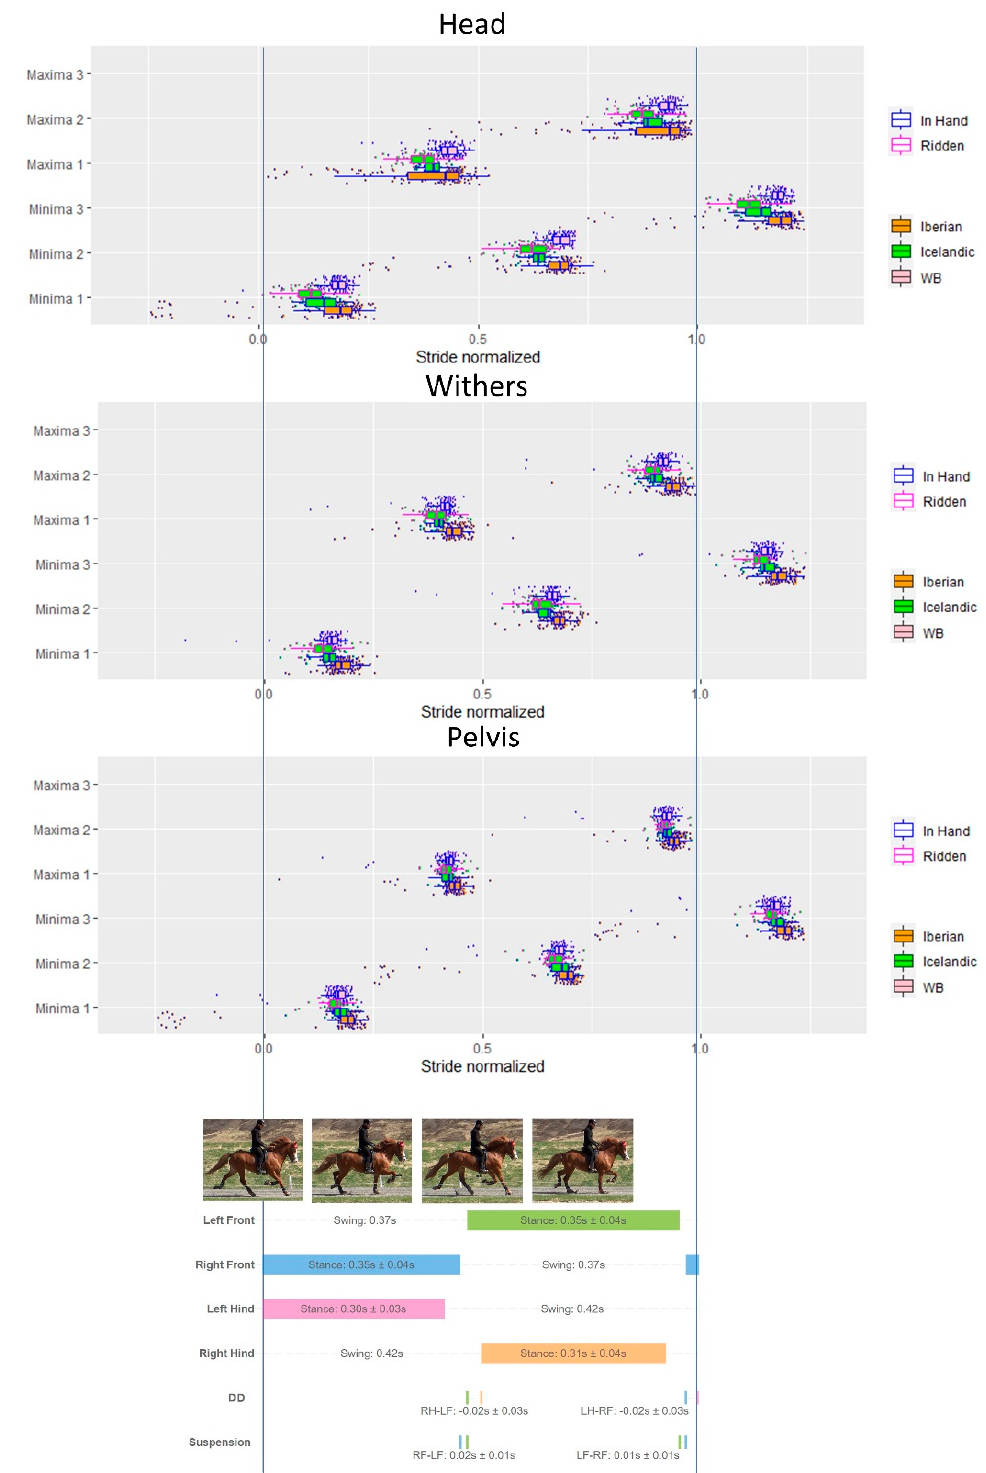
Figure 4. Combined data for the three breeds (Iberian, Icelandic, Warmblood) to show timing of minima (Min) and maxima (Max) on y -axis of the head, withers and pelvis during a normalized trot stride, including data from in hand and ridden conditions. Each dot represents a stride. Stance bars for each limb indicate mean and standard deviation (SD) of all strides across breeds and conditions. Diagonal dissociation (DD) and SD for right hindlimb (RH)–left forelimb (LF) diagonal and left hindlimb (LH)–right forelimb (RF) diagonal are presented. Suspension time is also presented.